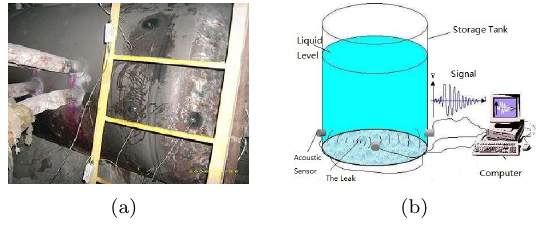
Figure 2. An example for leakage detection by using acoustic